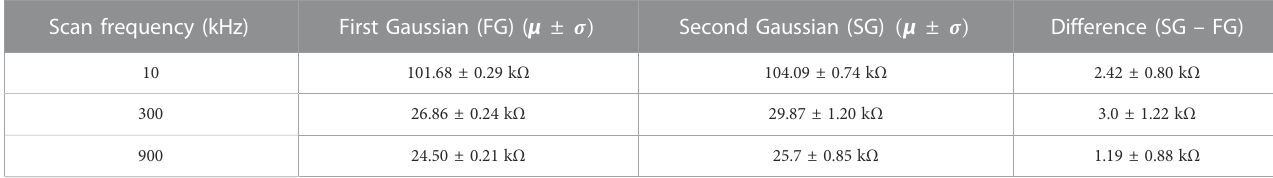
TABLE 1 Mean ( μ ) values with standard deviation ( σ ) of the fi rst and the second Gaussian peaks and difference in k Ω between the two Gaussian peaks. Scan frequency